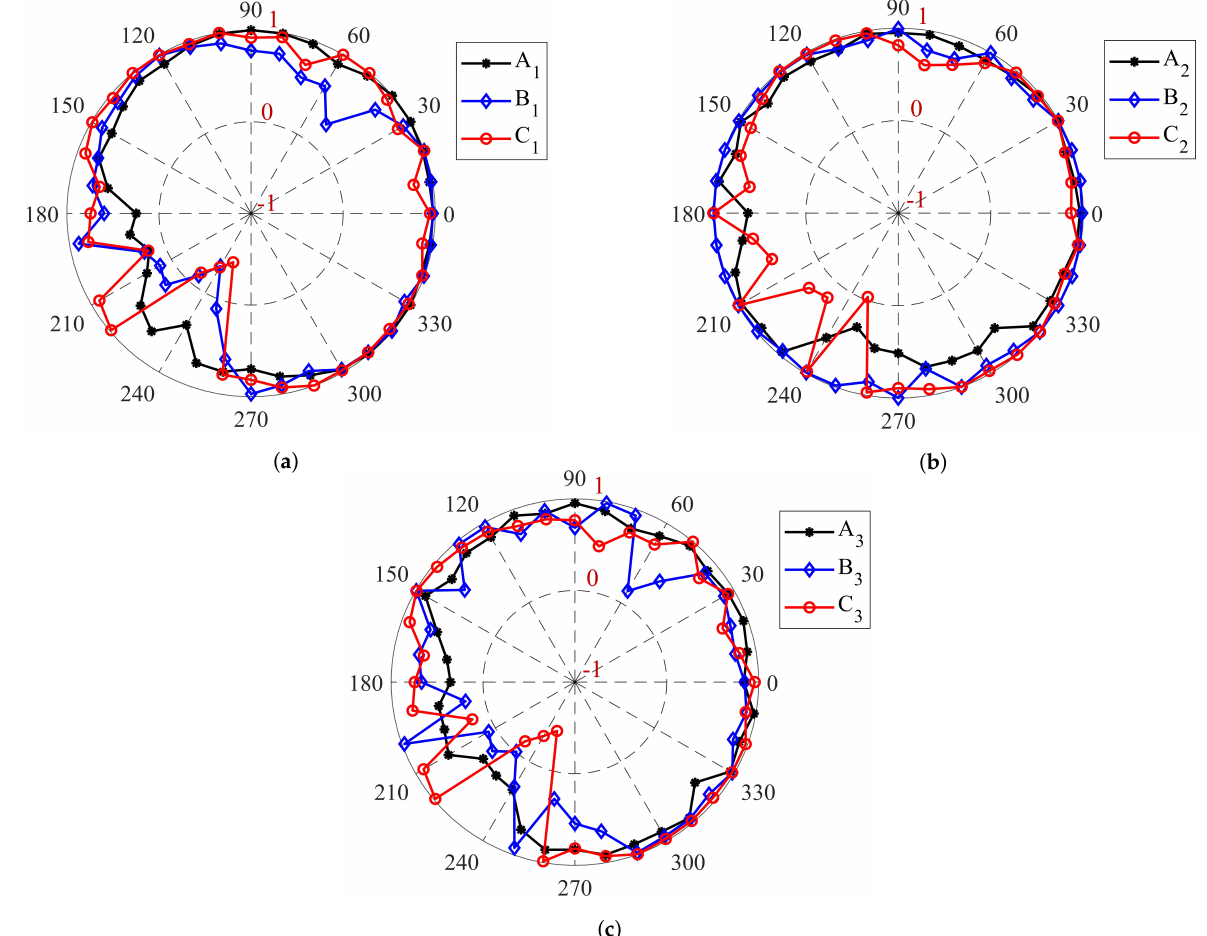
Figure 15. Circular diagrams of the normalized second-order work of ( a ) specimen S 1 (confining pressure P 0 = 100 kPa and strain rate ˙ (cid:101) 3 = 0.05 s − 1 ), ( b ) specimen S 2 (confining pressure P 0 = 250 kPa and strain rate ˙ (cid:101) 3 = 0.05 s − 1 ), and ( c ) specimen S 3 (confining pressure P 0 = 100 kPa and strain rate ˙ (cid:101) 3 = 0.15 s − 1 ) for different values of η . All of the specimens have a positive second-order work in the isotropic stress state (points A 1 , A 2 , and A 3 ). In the other words, all of the specimens are in the stable stress state at the begging of the compaction process. For the specimen S 1 , the cone of the